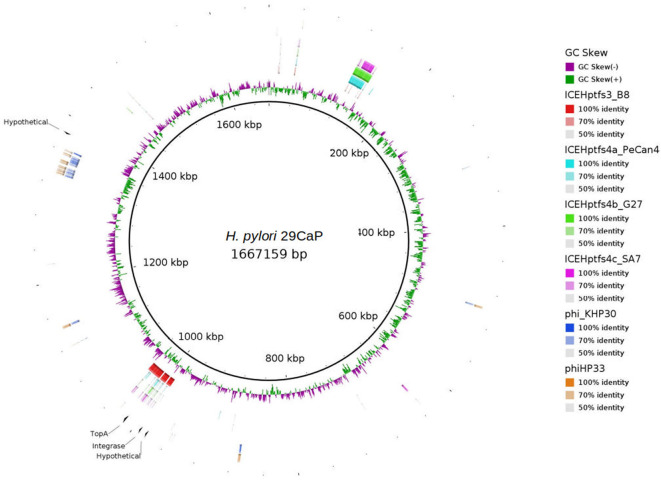
Gastric cancer-associated protein orthologous groups (POGs) mapped on H. pylori 29CaP genome. tblastx comparisons of the four ICEs described, and KHP30 and phiHP33 bacteriophage genomes with H. pylori 29CaP genome to show the regions where POGs are encoded. Alignments and circular map were obtained with BRIG v0.95.